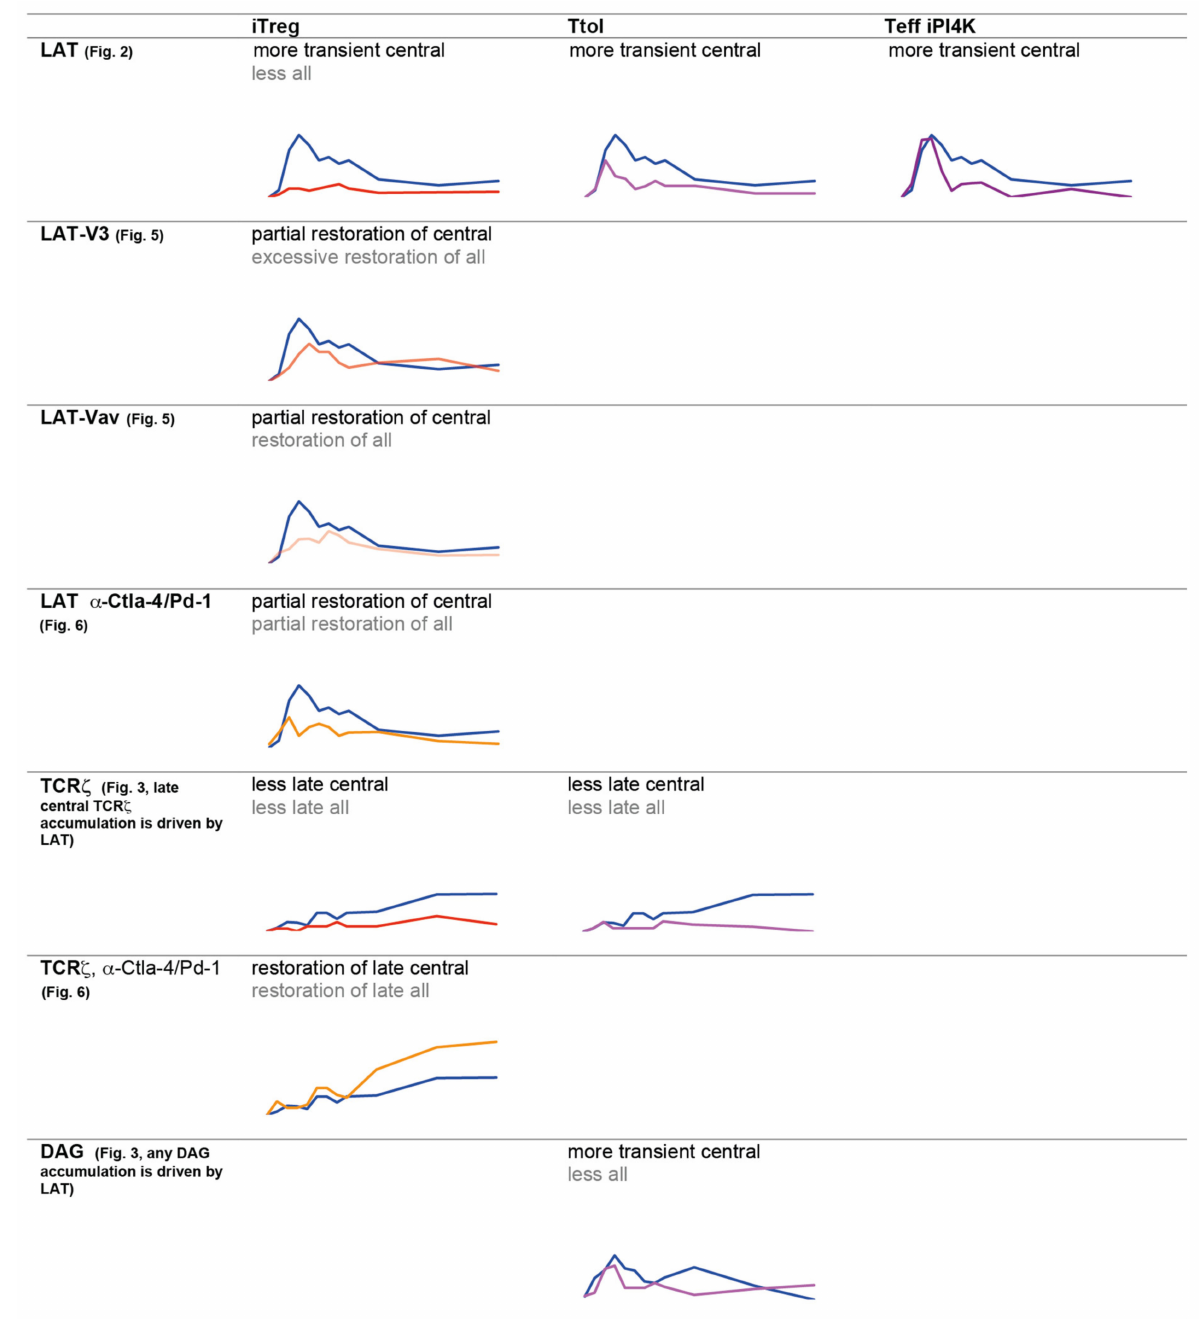
Figure 4. Summary of central accumulation phenotypes. Changes in accumulation phenotypes of the different Tg4 cell types with regulatory capability in comparison to Teff cells are summarized across all experiments with a focus on central accumulation of the